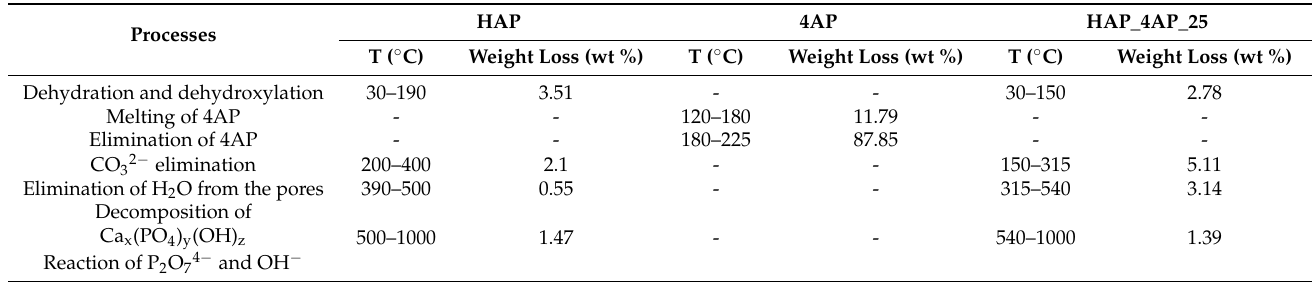
Table 1. Weight loss (wt %) of HAP, 4AP, and HAP_4AP_25, and occurring processes during the thermal